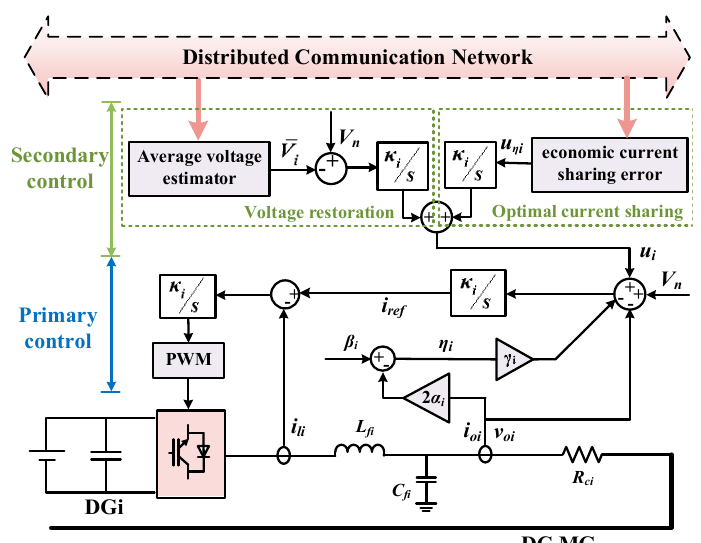
Figure 1. Hierarchical control structure.